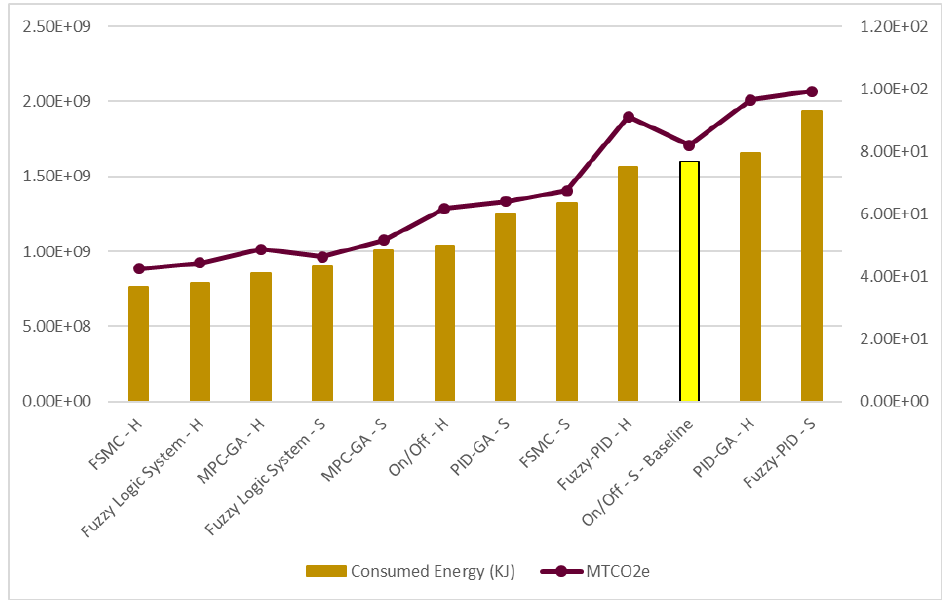
Figure 14. Consumed Energy (left vertical axis) and CO 2 emission (right vertical axis) by applying different control algorithms in steam (S) and hydronic (H) system.